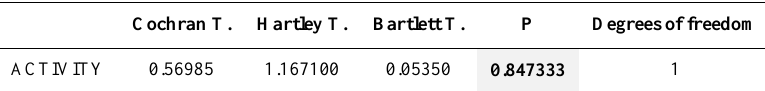
Table 6. Test of variance homogeneity